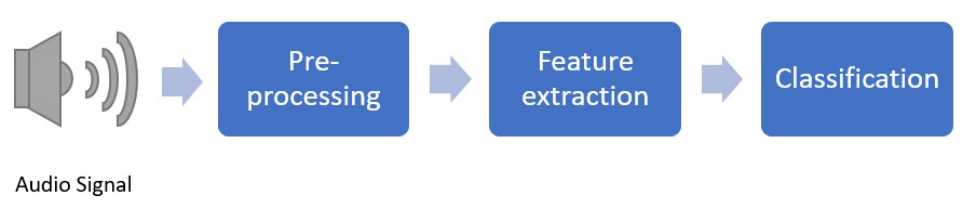
Figure 3. Typical sound classification